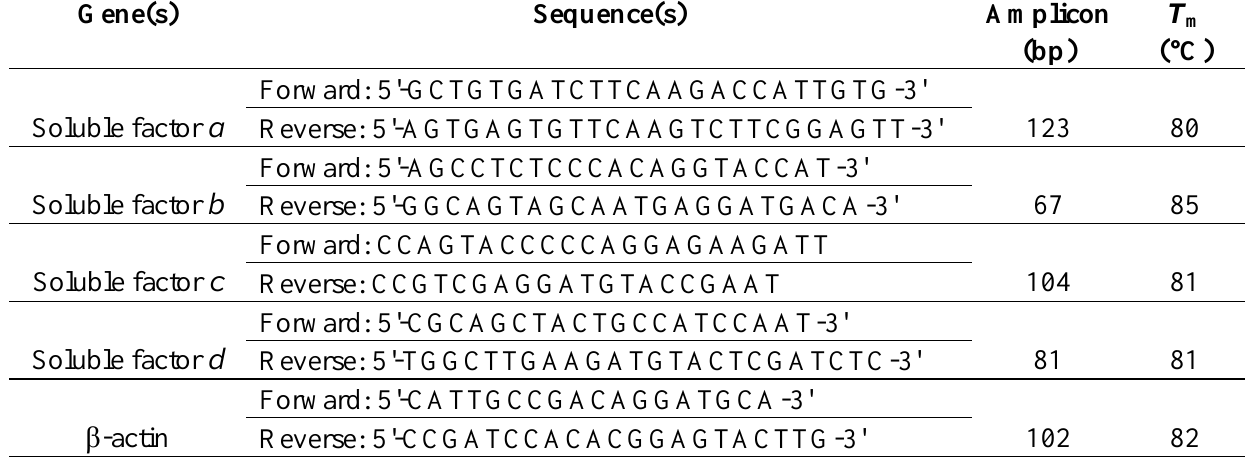
Table 3 . Primer design for real-time